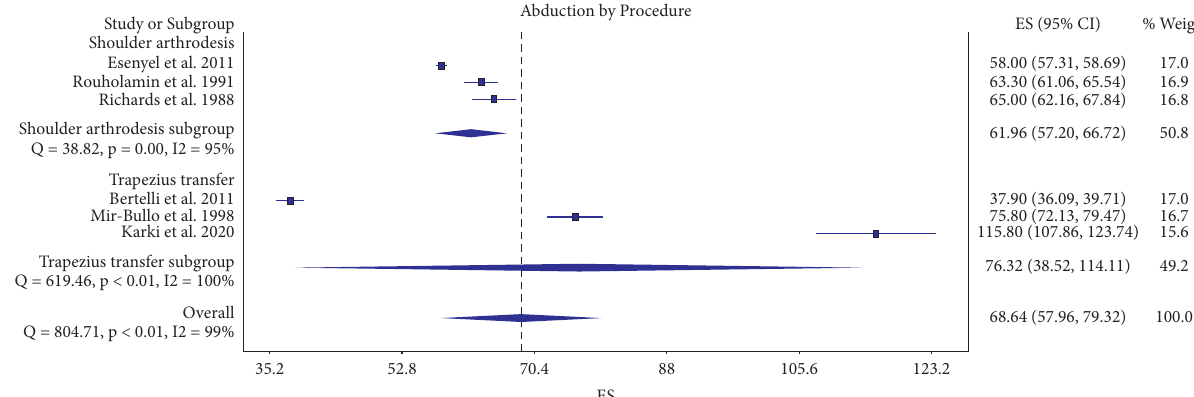
Figure 6: Forest plot illustrating active shoulder abduction for shoulder arthrodesis versus upper trapezius